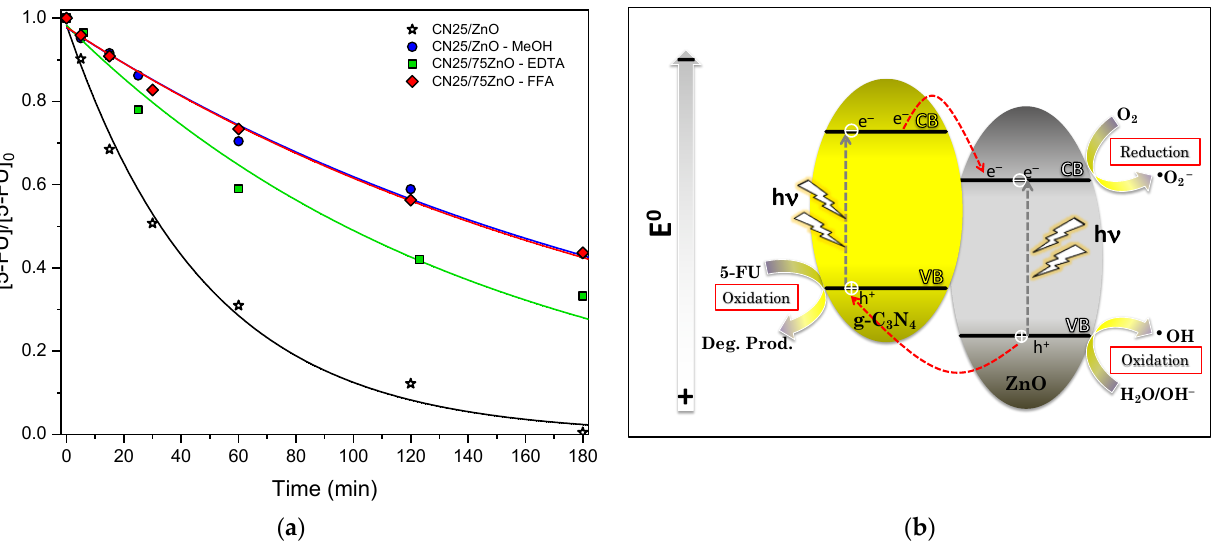
Figure 8. ( a ) Effect of radical/hole/non-radical scavengers (MeOH/EDTA/FFA) on the photocatalytic degradation of 5-FU using the CN25/ZnO composite. ( b ) Scheme of the tentative photocatalytic mechanism with CN/ZnO